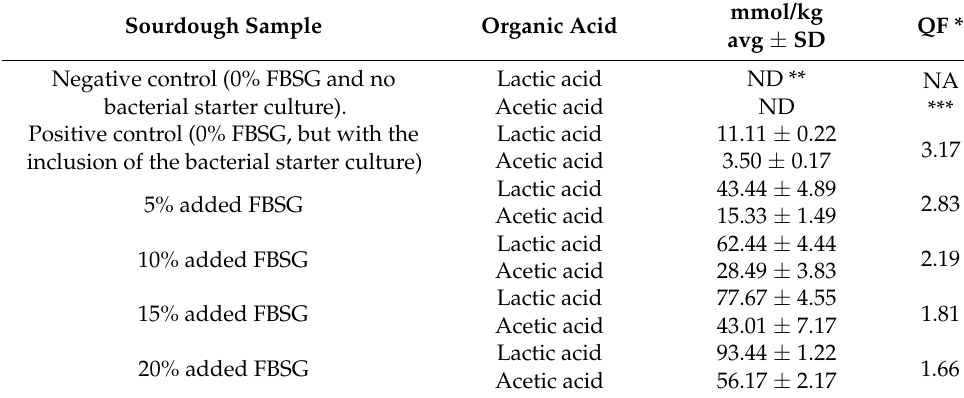
Table 2. Lactic acid and acetic acid content of sourdough breads produced in this